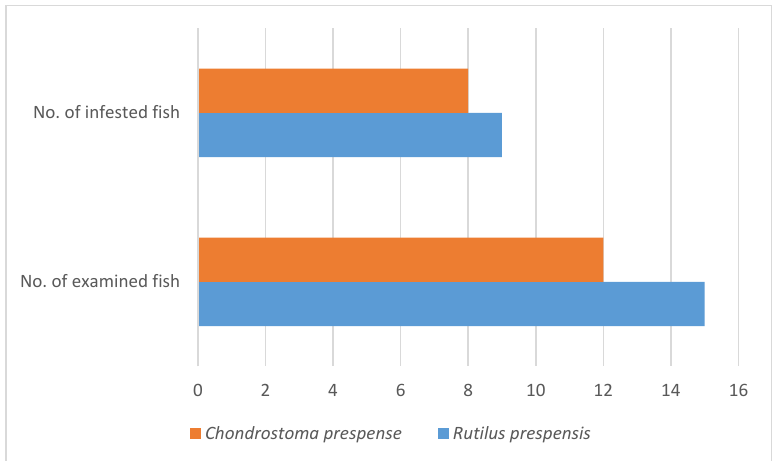
Figure 3. Glochidia of Anodonta cygnea on the fins of Rutilus prespensis from the Macedonian part of Lake Prespa—original photos: ( A )—Glochidia found on the fin of a fresh Rutilus prespensis speci- men; ( B )—microscopic slide of Glochidia.